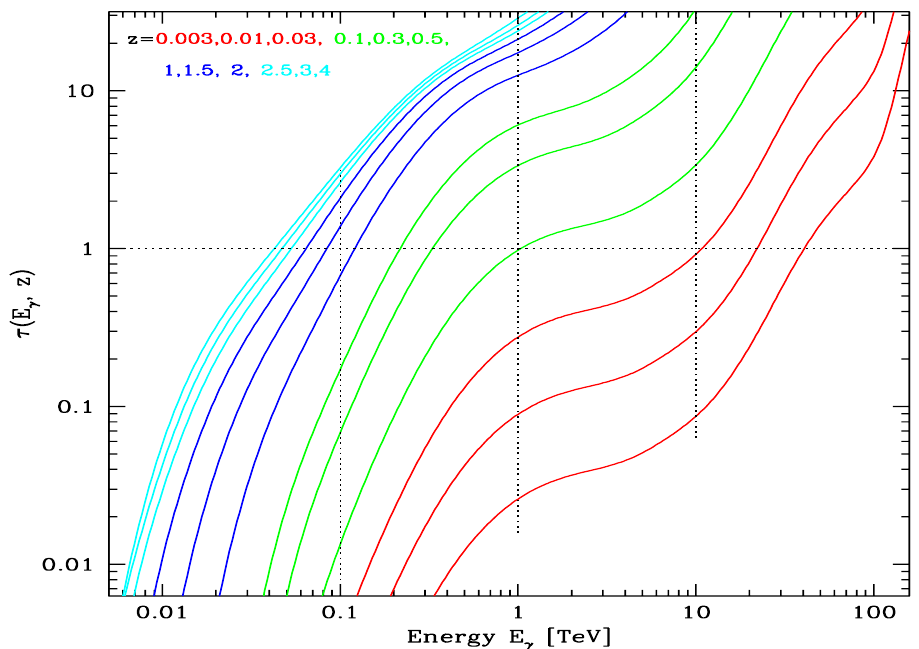
Figure 4. The optical depth by photon–photon collision as a function of the photon energy for sources located at z = 0.003,0.01,0.03,0.1,0.3,0.5,1,1.5,2,2.5,3,4, from bottom to top. The fast rise at the high τ and E γ values is due to the large volume density of CMB photons. The graph is based on the model by